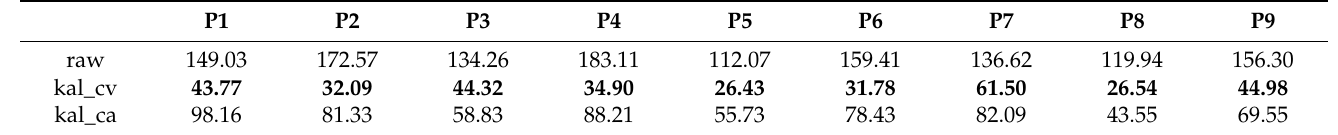
Table 3. Variance.